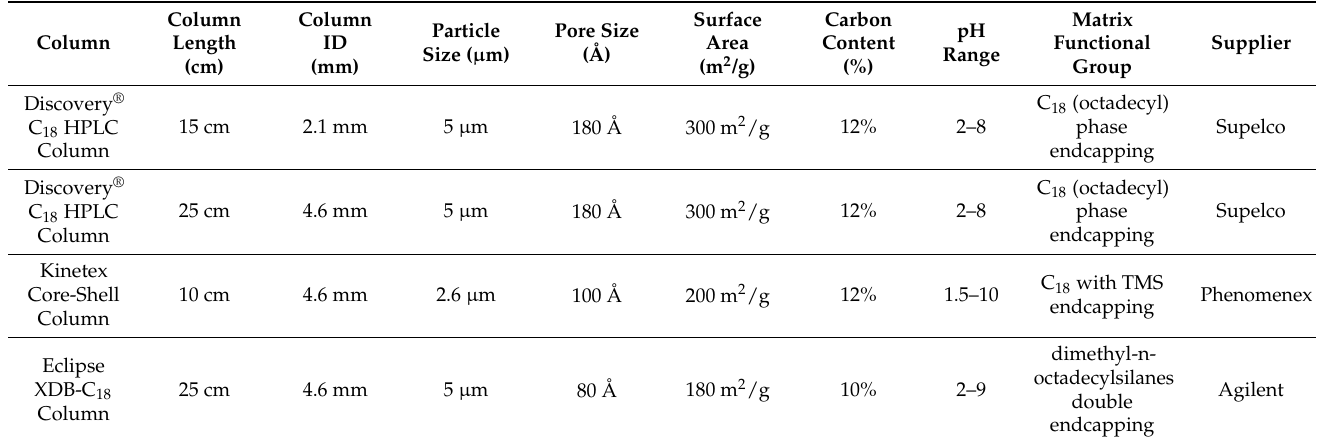
Table 3. Characteristics of columns tested in this